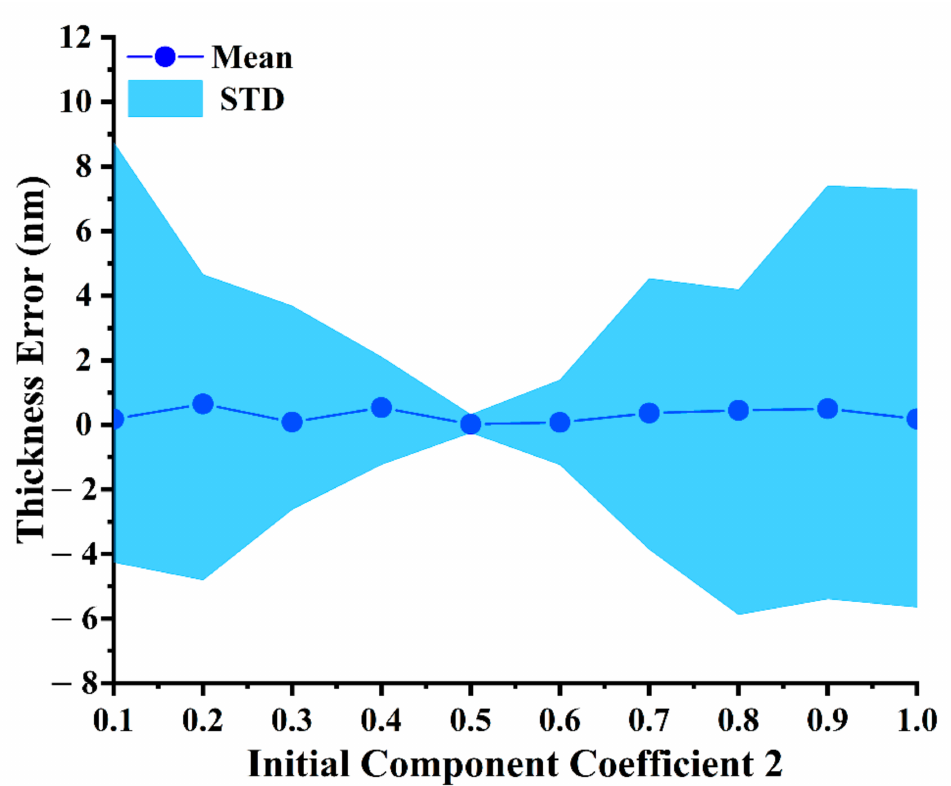
Figure 5. The influence of the initial component